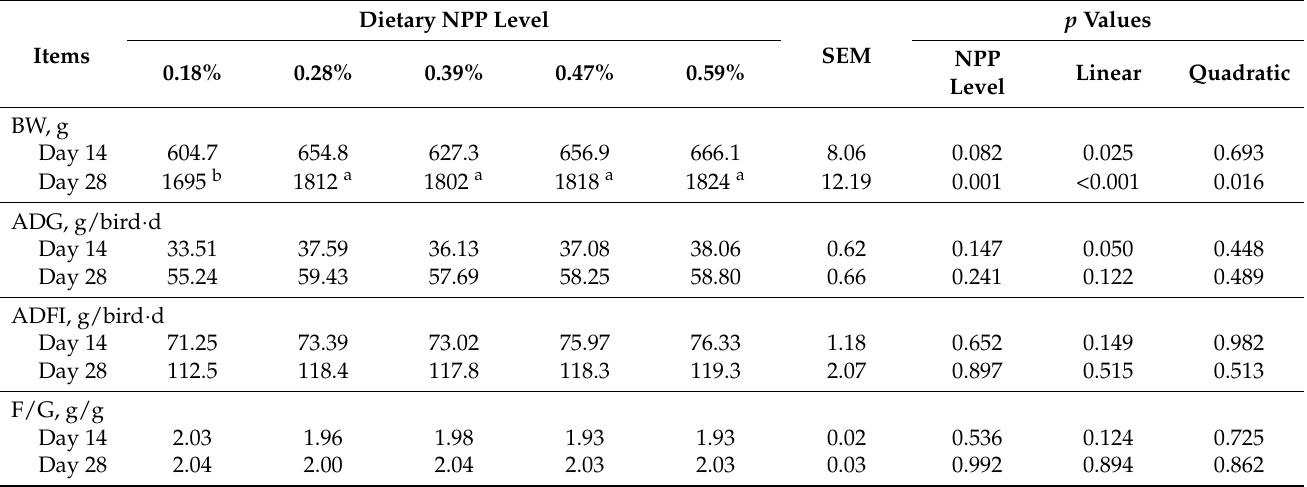
Table 2. Effects of dietary non-phytate phosphorus (NPP) levels on the growth performance of gosling at 14 and 28 days of age.